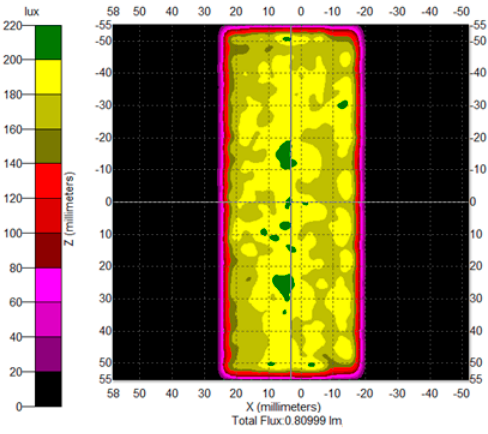
Figure 5. Illumination map observed by a detector.